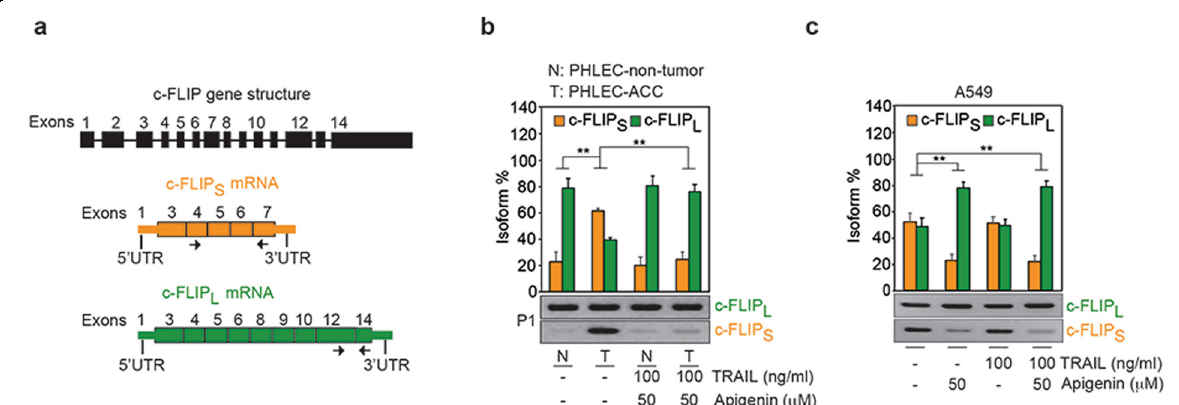
Fig. 4 Apigenin modulates alternative splicing of c-FLIP isoforms. a Schematics of the c-FLIP gene structure including introns represented by a line and exons represented by fi lled numbered boxes. Splice isoforms of c-FLIP mRNA, c-FLIP S (in orange), and c-FLIP L (in green) including exons and UTRs represented by thinner fi lled boxes. b , c The alternative splicing of c-FLIP S and c-FLIP L was determined by RT-PCR using isoform-speci fi c primers (indicated by the black arrows in [ a ]). Quanti fi cation of the isoforms observed in the gels was done by densitometry. The percent of each isoform was calculated as follows: (density of one isoform)/(density of the sum of the two isoforms) × 100. Bar plots summarize the quantitation and represent the mean ± SEM. The picture in the bottom is a representative image of an agarose gel depicting the c-FLIP S and c-FLIP L isoforms obtained by RT-PCR and separated by gel electrophoresis. b PHLECs isolated from paired nontumor (N) and adenocarcinoma tumor (T) biopsies from human patients (P1 – P3) pretreated for 18 h with 50 μ M apigenin or DMSO (-) followed by treatment with 100 ng/ml TRAIL for 6 h or controls treated only with DMSO (-) then, the alternative splicing of c-FLIP S and c-FLIP L was determined by RT-PCR using isoform-speci fi c primers. c A549 NSCLC cells pretreated with 50 μ M apigenin or DMSO (-) for 18 h followed by treatment with 100 ng/ml TRAIL for 6 h, apigenin or TRAIL alone; then, the alternative splicing of c-FLIP S and c-FLIP L was determined by RT-PCR using isoform-speci fi c primers (black arrows shown in a ). All data are expressed as the mean ± SEM. (Fig. 4b, n = 3; Fig. 4c, n = 4; ** P < 0.01; and analyses were performed by two-way ANOVA followed by Tukey ’ s post hoc